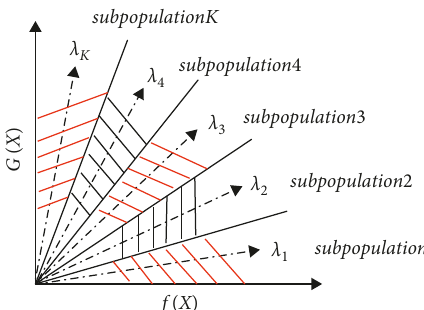
Figure 2: Illustration of the subpopulation